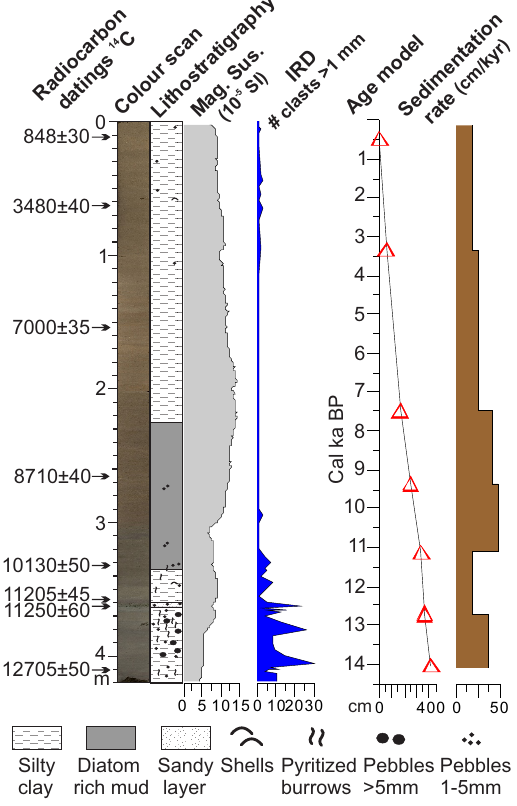
Figure 3. Left: lithology and colour scan of core JM10-330GC, to- gether with magnetic susceptibility and concentration of ice-rafted debris (IRD) per gram dry weight sediment. Arrows indicate po- sitions of original radiocarbon dates. Right: age model and calcu- lated sediment accumulation rates. Red triangles indicate radiocar- bon